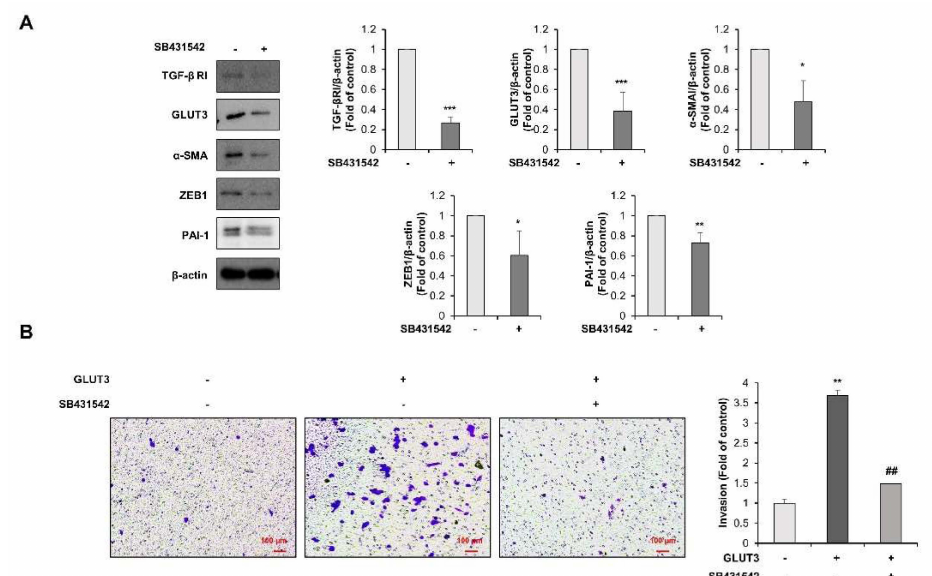
Figure 4. TGF- β signaling pathway regulates GLUT3-induced EMT in CRC cells. ( A ) Lysates of the HCT116 cells treated or not with 10 µ M SB431542 for 48 h. Western blot analysis was conducted for measuring the protein levels of TGF- β RI, GLUT3, α -SMA, ZEB1 and PAI-1. ( B ) Cell invasion was analyzed after 24 h post transfection with GLUT3/pEJ-3HA (1.5 µ g) and treated or not with 10 µ M SB431542 for 24 h to allow for the permeabilization of the transwell membrane. The membrane was stained with 0.2% crystal violet. Scale bar, 100 µ m. TGF- β , transforming growth factor- β ; GLUT3, glucose transporter 3; EMT, epithelial–mesenchymal transition; TGF- β RI, transforming growth factor- β receptor I; α -SMA, α -smooth muscle actin; ZEB1, zinc finger E-box binding homeobox 1, PAI-1, plasminogen activator inhibitor-1. Data are the mean ± standard deviation. Statistical significance was analyzed by analysis of variance. * p < 0.05, ** p < 0.01, and *** p < 0.001, significantly different compared with control; ## p < 0.01 compared to the GLUT3